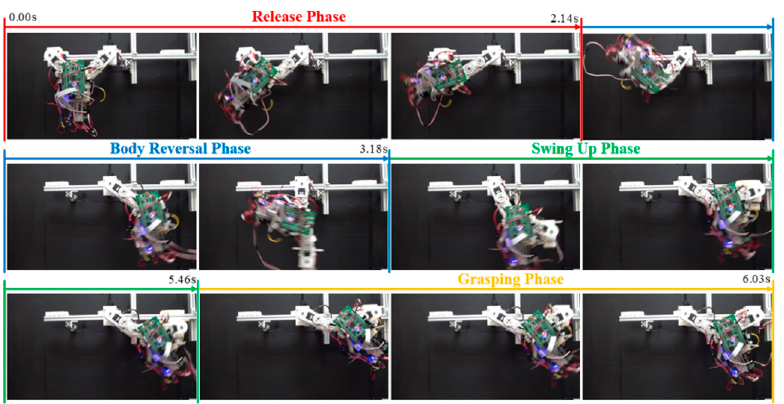
Figure 24. Snapshots showing the ledge brachiation experiment (Exp. (g): distance: 250 mm, elevation: 0 mm).